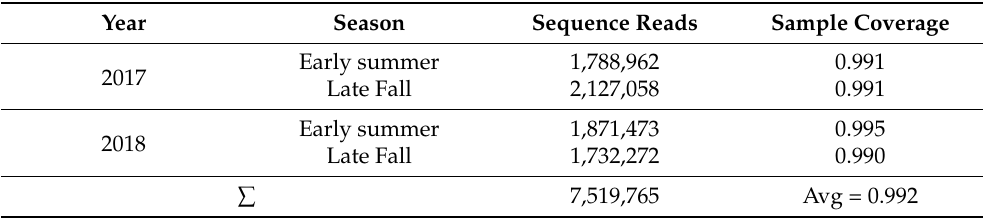
Table 1. Summary of quality bacterial sequence reads and sample coverage by year and